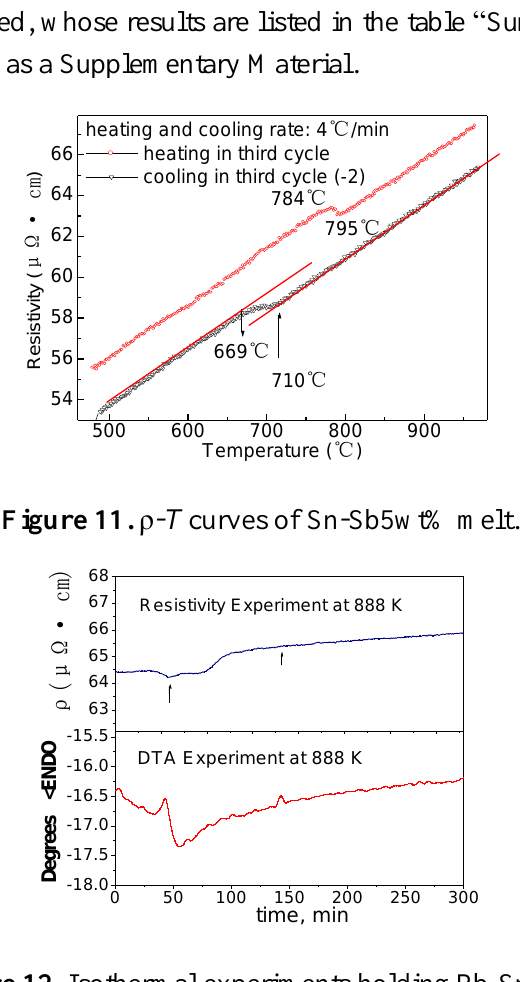
Figure 12. Isothermal experiments holding